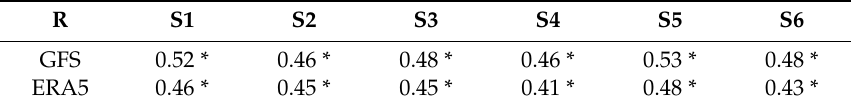
Table 3. Average correlation coefficients (Rs) of different combinations of initial data and parameterization schemes.